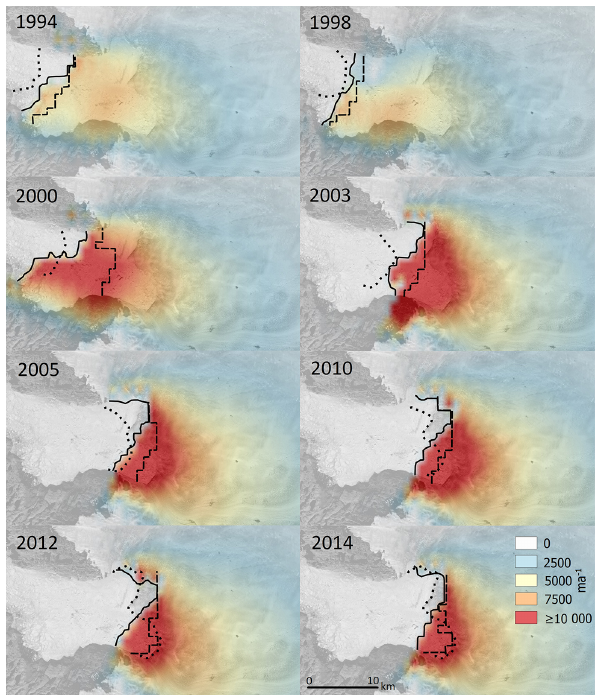
Figure 2. Modelled velocities at Jakobshavn Isbræ for December are shown for 8 different years. The black line represents the mod- elled front positions, the black dotted line denotes the observed front position, and the thick black dashed line represents the mod- elled grounding line position. The velocities are superimposed over a Landsat 8 image acquired in August